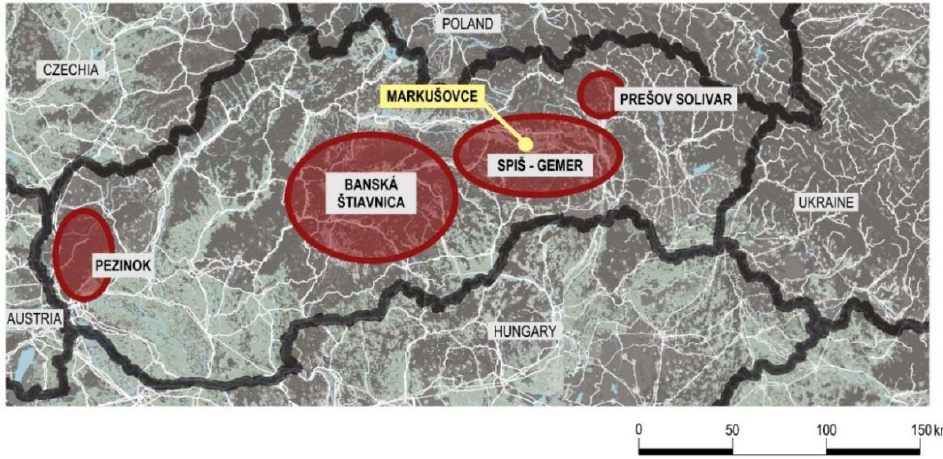
Figure 3. The main mining regions in Slovakia (figure from the